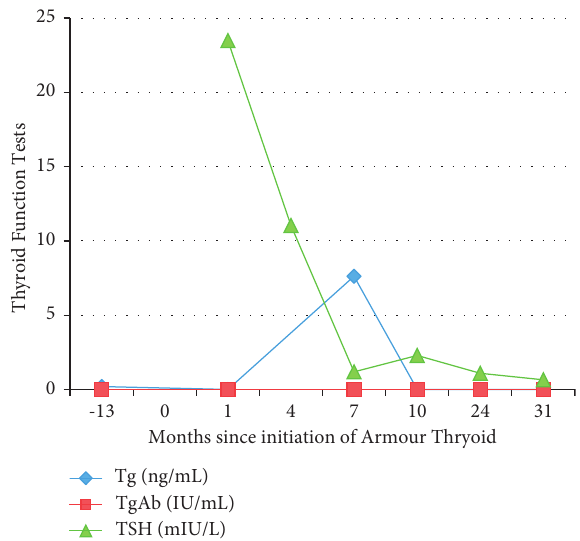
Figure 1: Trend of TSH and thyroglobulin results over time in case